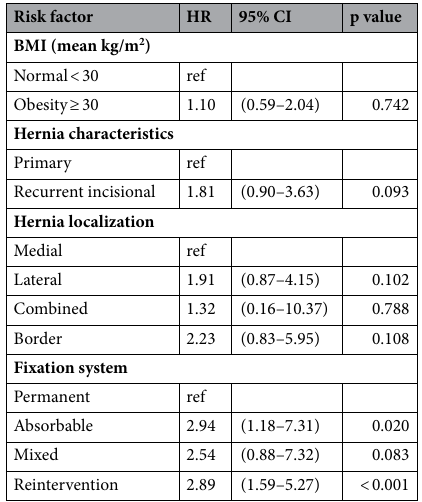
Table 5. Multivariable analysis of independent risk factors and relative risk of IH recurrence; HR (Hazard Ratio), 95% CI (Confidence Interval) and p value.